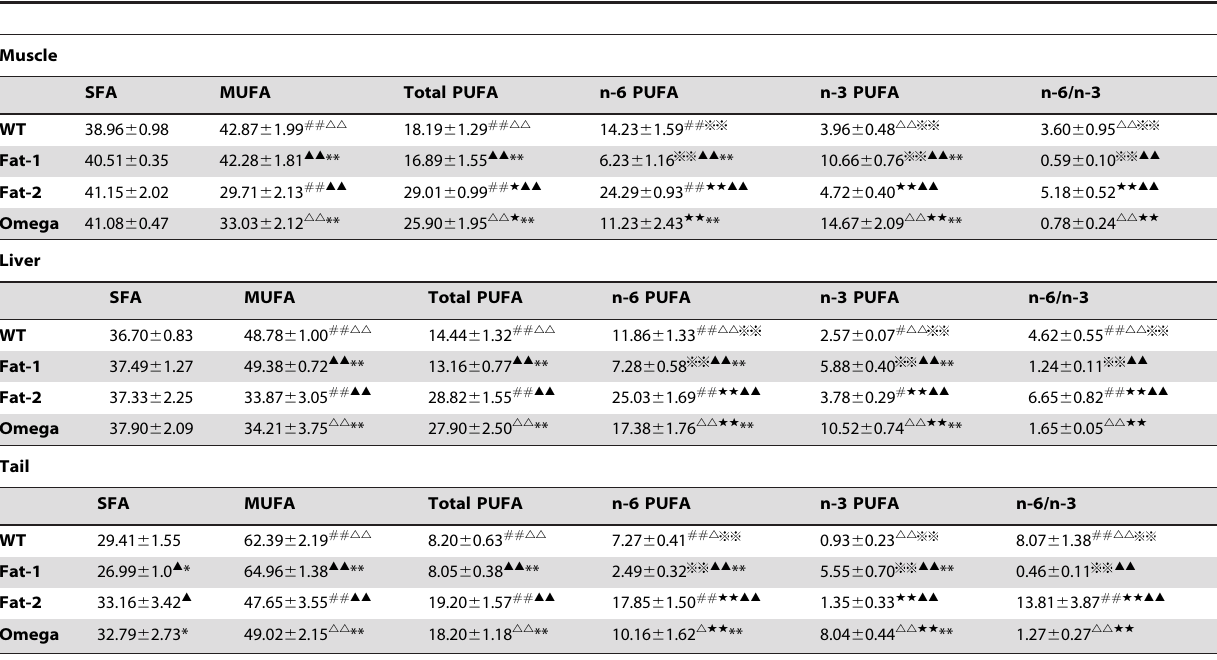
Table 1. Comparison of the fatty acid profiles of various tissues among the four genotypes.